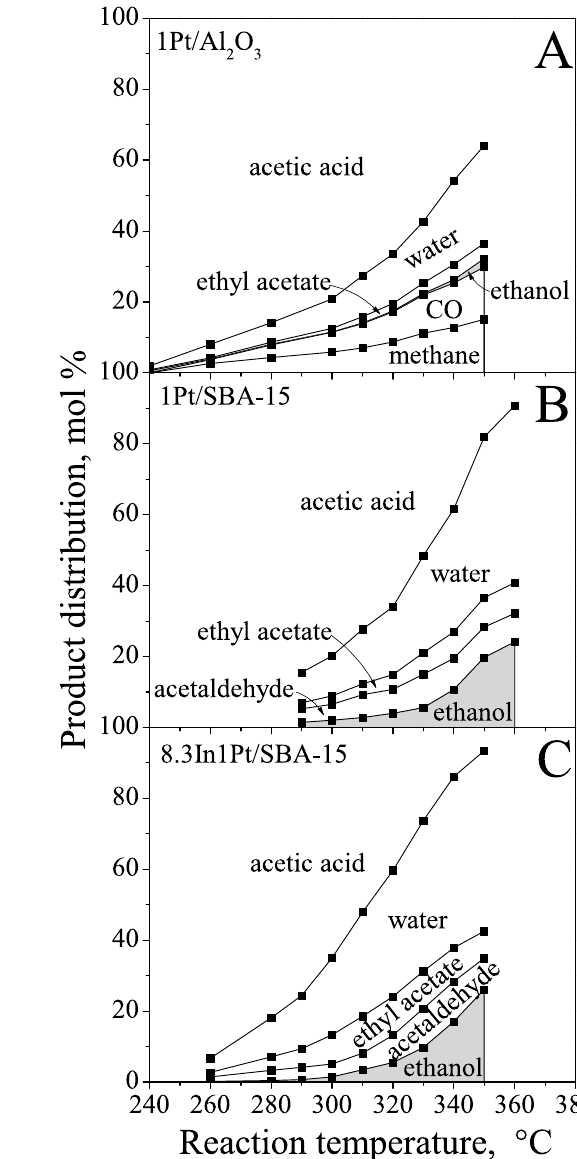
Figure 1 : Stacked area graphs of product distribution of AA hydroconversion as a function of reaction temperature over monometallic (a) Cu/Al SBA-15 catalysts at 21 bar total pressure and 1 g